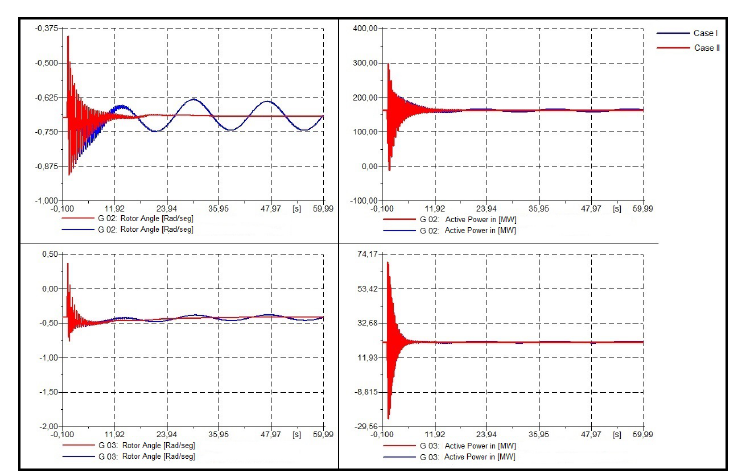
Figure 13. Rotor angle [rad] and Active Power [MW]-three phase fault at bus 9.